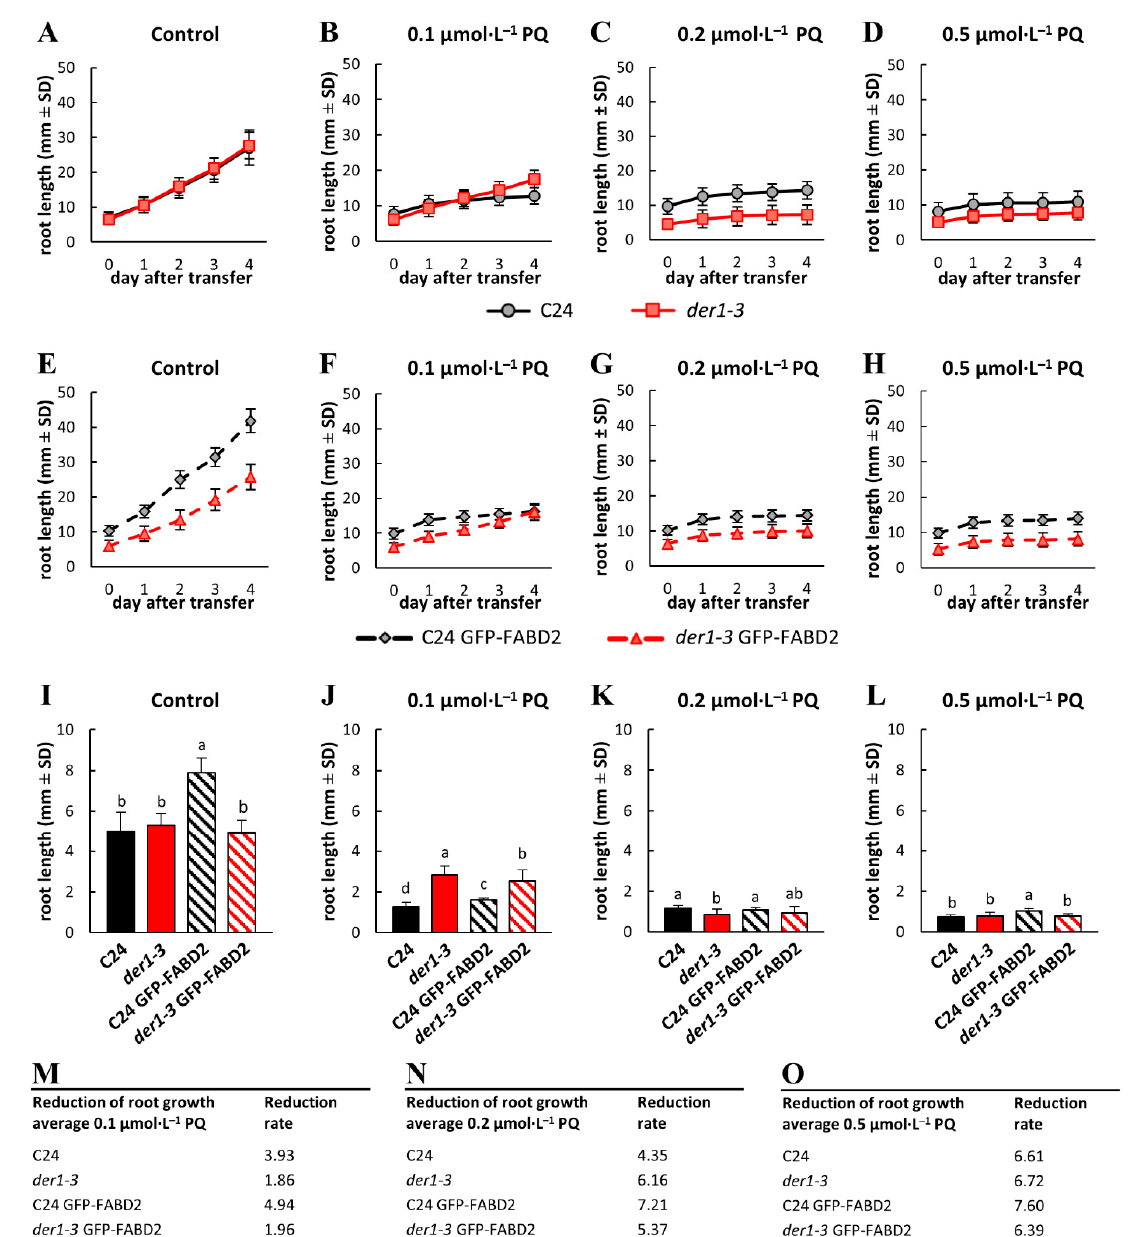
Figure 3. Root growth rate in plants of the control C24, der1–3 mutant and transgenic C24 and der1–3 lines expressing pro35S::GFP:FABD2 after their transfer to PQ-containing media. 3-day-old plants germinated on the control media were transferred to PQ-containing media and the root growth rate was analyzed within the subsequent 4 days. ( A – D ) Root growth rate of the control C24 and der1–3 mutant plants on the control media ( A ) and on media containing 0.1 ( B ), 0.2 ( C ) and 0.5 ( D ) µmol·L − 1 of PQ. ( E – H ) Root growth rate of the transgenic C24 line carrying GFP-FABD2 and the transgenic der1–3 line carrying GFP-FABD2 on the control media ( E ) and on media containing 0.1 ( F ), 0.2 ( G ) and 0.5 ( H ) µmol·L − 1 of PQ. ( I – L ) Average root growth per 24 h on the control media ( I ) and on media containing 0.1 ( J ), 0.2 ( K ) and 0.5 ( L ) µmol·L − 1 of PQ. ( M – O ) Reduction ratio (fold change in respect to control) of the average root growth in the respective lines on media containing 0.1 ( M ), 0.2 ( N ) and 0.5 ( O ) µmol·L − 1 of PQ. Experiments were repeated two times with 16 plants per line (control) and 12 plants per line (PQ). Different lowercase letters above the bars ( I – L ) represent statistical significance ac- cording to one-way ANOVA and subsequent LSD test at p value < 0.05.